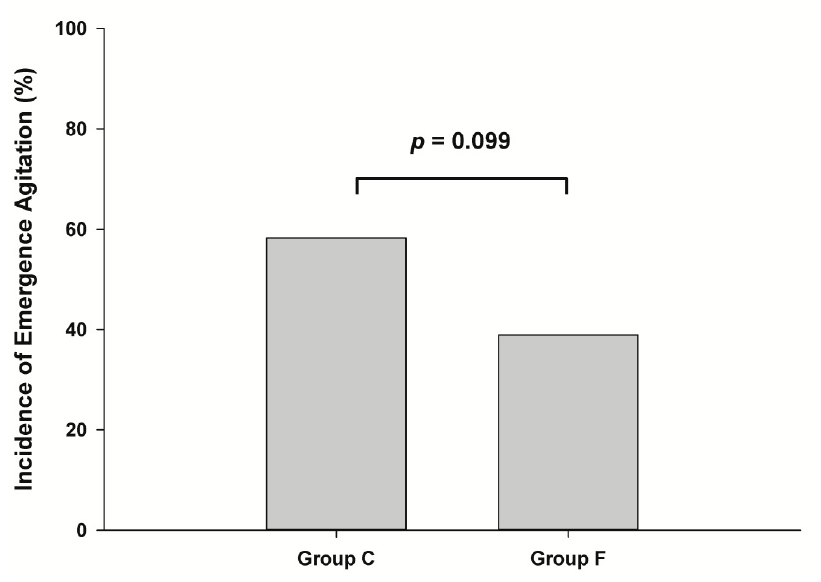
significant differences between the two groups.